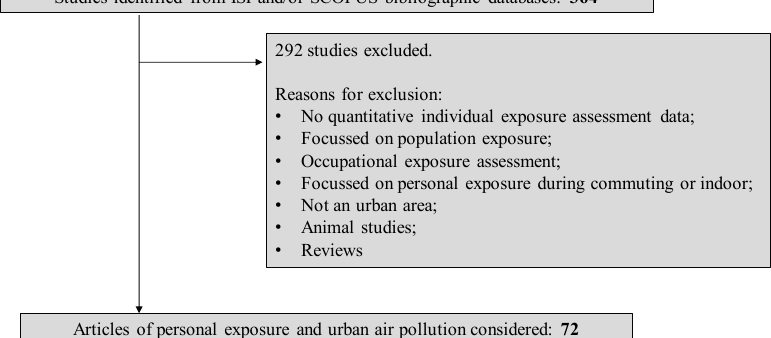
Figure 3. Summary of the article selection process.